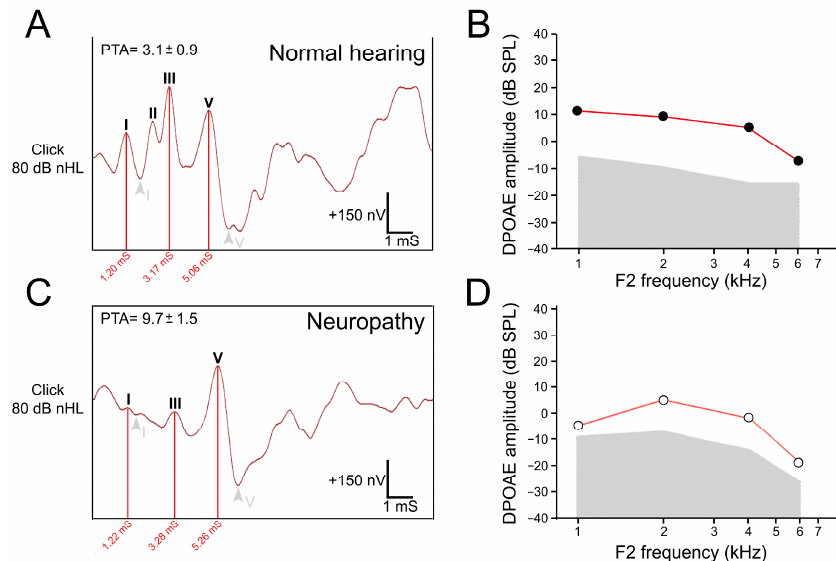
Figure 2. Auditory brainstem responses (ABRs) and distortion product of otoacoustic emissions (DPOAEs) recorded from one normal hearing control ( A , B ) and one patient with speech understanding difficulties ( C , D ). ( A ) ABRs were recorded at 80 dB nHL (decibels normal hearing level) with normal amplitudes, latencies, and morphology. ( B ) No abnormalities were detected in the DPOAEs. ( C ) A patient with speech understanding difficulties showed a clear decrease in the amplitude of waves I, II, and III. The I-V interval was 4.04 vs. 3.86 for the patient and a normal hearing subject, respectively. ( D ) DPOAEs were still present in this patient. PTAs: mean of pure-tone audiometry thresholds recorded at 250, 500, 1000, 2000, 3000, and 4000 Hz. Note that PTA is within the normal range in the patient with speech understanding difficulties. The audiologic results of this patient suggest a hidden auditory neuropathy.